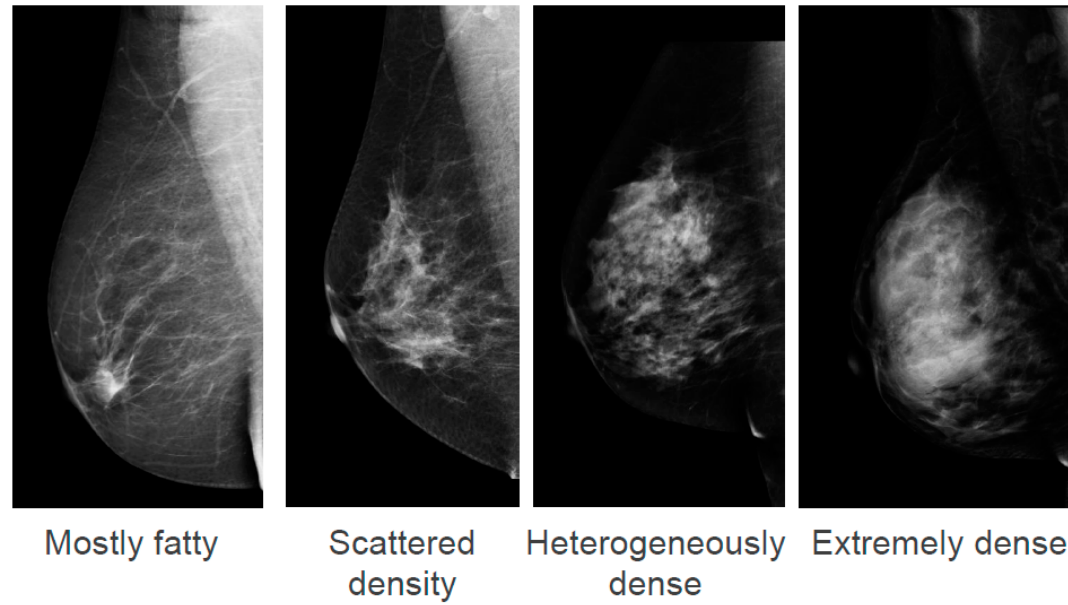
Figure 1. American College of Radiology Breast Imaging Reporting and Data System (BI-RADS) classification system of 4 density categories: “Mostly fatty”, “Scattered density”, “Heterogeneously dense”, and “Extremely dense”. Reproduced with permission from InforMD (www.informd.org.au).